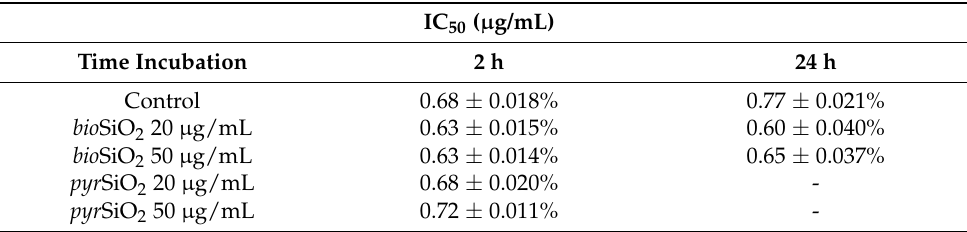
Figure 11. Percentage of hemolysis of erythrocytes. The osmotic resistance of red blood cells modified by SiO 2 nanoparticles after 2 h and 24 h of incubation. Statistical evaluation of differences was made using the ANOVA I and Tukey’s post hoc test, at significance levels of p < 0.01 (*) with respect to control.2.7. The microscopic studies of erythrocytes shapes. Table 1. The level of osmotic resistance in relation to the concentration of psychological saline (IC 50 ) which is responsible for 50% hemolysis of erythrocytes which were modified by SiO 2